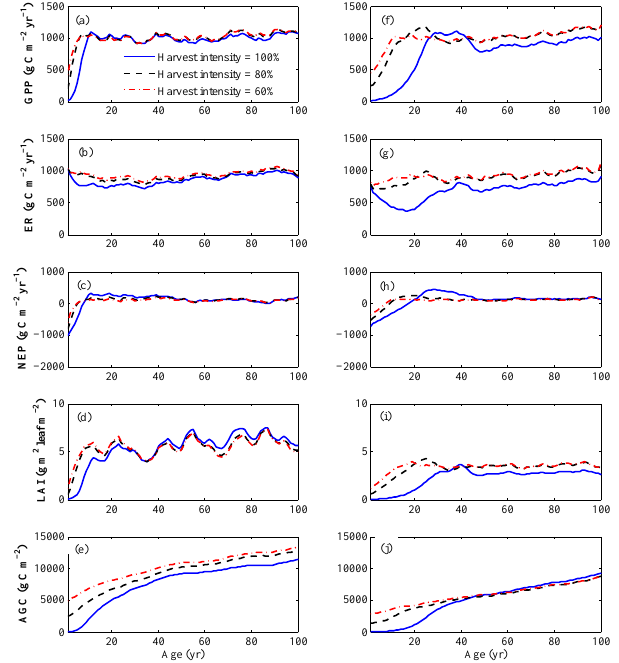
Figure 8. Sensitivity of carbon fluxes (GPP, gross primary produc- tion; ER, ecosystem respiration; NEP, net ecosystem production) and stand characteristics (LAI: leaf area index; AGC: aboveground carbon stock) to changes in harvest intensity (reduced by 0.2 and 0.4 compared to 1 for assumed clear-cuts used in the model tests) for (a–e) deciduous broadleaf forests (DBF) at Willow creek and (f–j) evergreen needleleaf forests (ENF) at a mature red pine site over a 100-year harvest cycle. The simulated curves were smoothed using a moving average filter with a span of